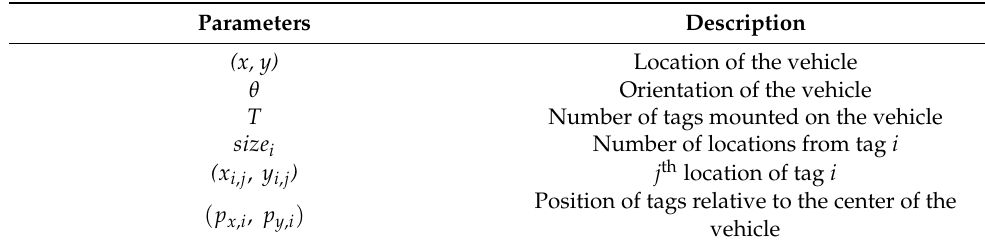
Table 2. Parameter table for pose estimation optimizer.